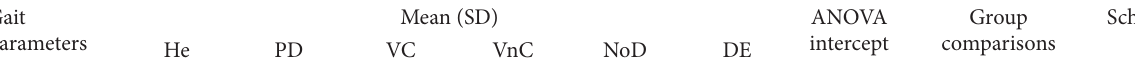
Table 4: Multiple group comparison between patient x control, visually x nonvisually controlled conditions, and depression x nondepression groups with several gait parameters. He = healthy control condition, PD = Patient’s condition, VC = visually controlled condition, VnC = visually noncontrolled condition, NoD = nondepressive condition, and DE = depressive